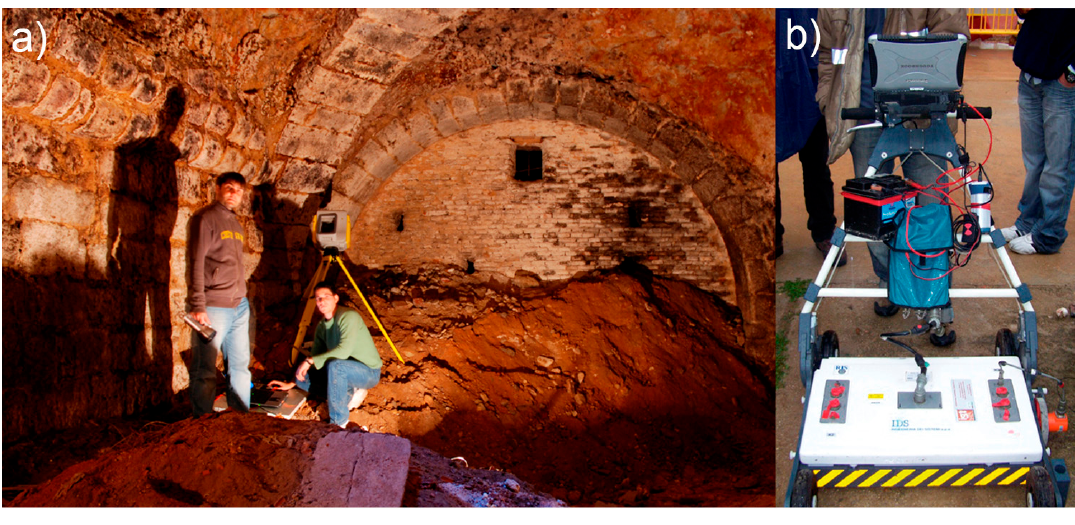
Figure 2. ( a ) Terrestrial laser scanner used for the recording of the external